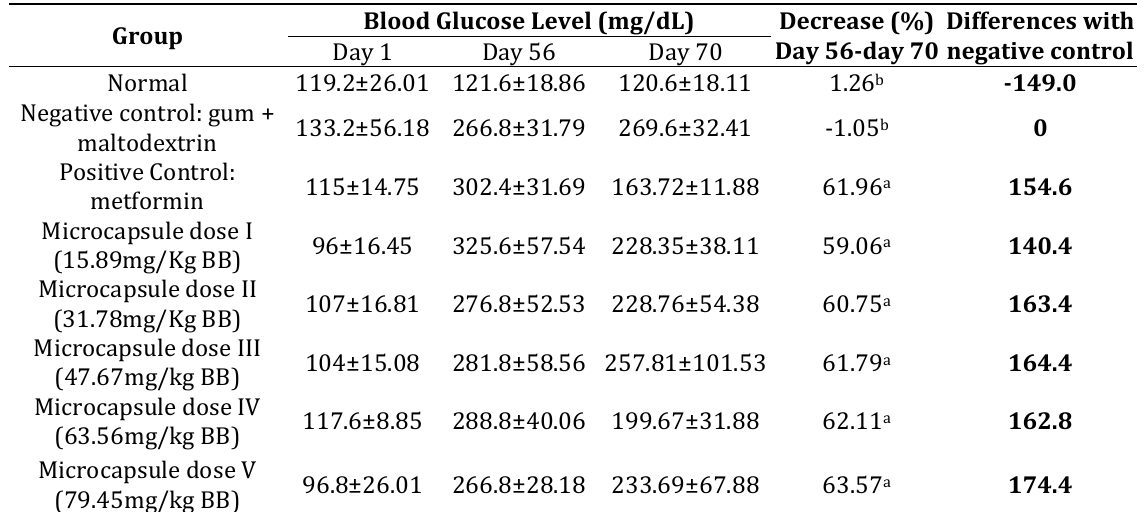
Table II. Average blood glucose levels of all test animal groups and percentage of decrease in blood glucose levels